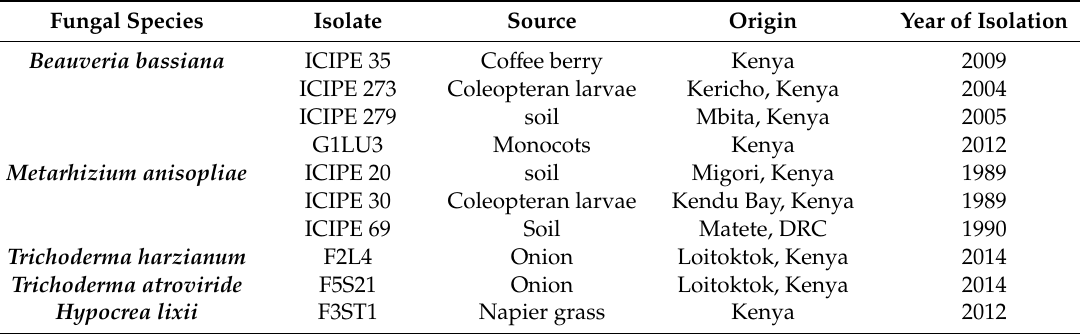
Table 1. List of fungal isolates used in this study and their